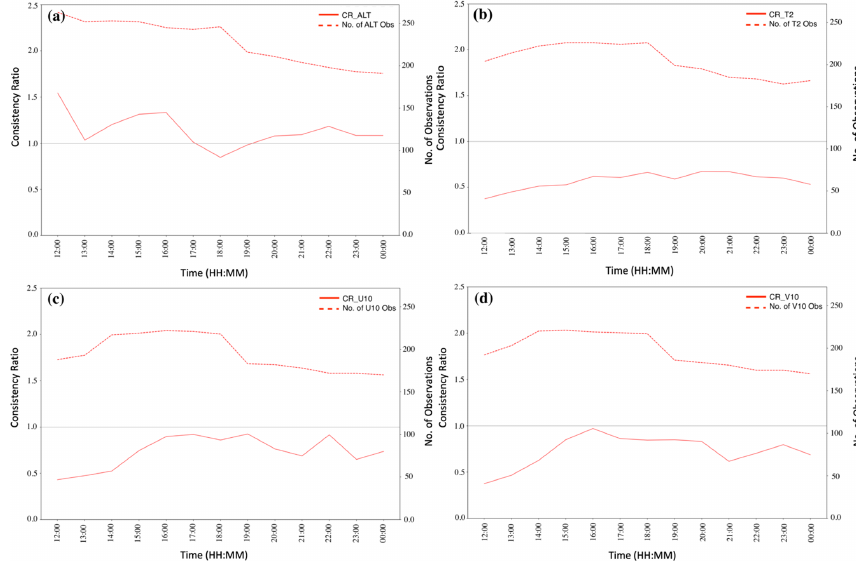
Figure 8. Evolution of the CR during the assimilation window for the METAR (a) altimeter and (b) 2m temperature observations and for the RSAMV (c) U wind and (d) V wind observations. The number of observations assimilated at each data assimilation cycle is depicted by the dotted